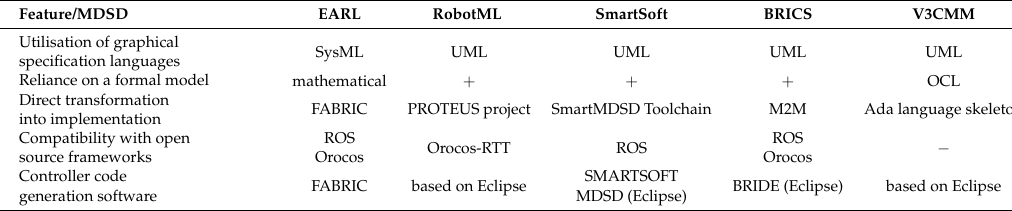
Table 9. Comparison of robotic MDSD language features: ( + ) exists, ( − ) does not exist. Feature/MDSD EARL RobotML SmartSoft BRICS V3CMM Utilisation of graphical specification